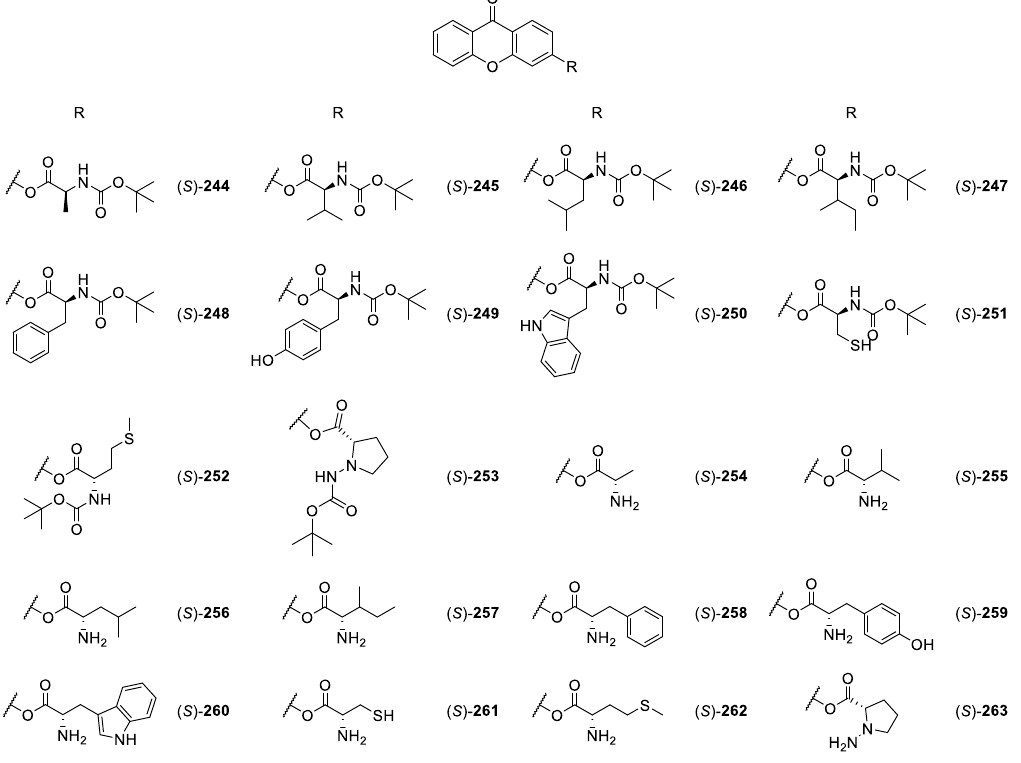
Figure 21. Structures of CDXs 244 – 263 , with antimicrobial and anti-inflammatory activities.